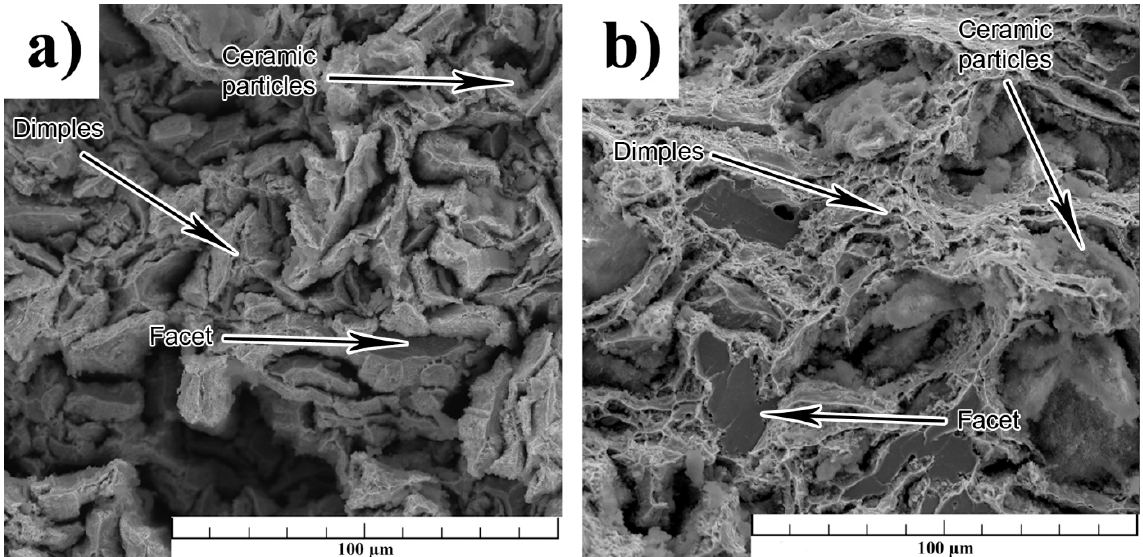
Figure 5. Fracture surfaces of ( a ) Zn-4HA and ( b ) Zn-4MO after the tensile measurements.